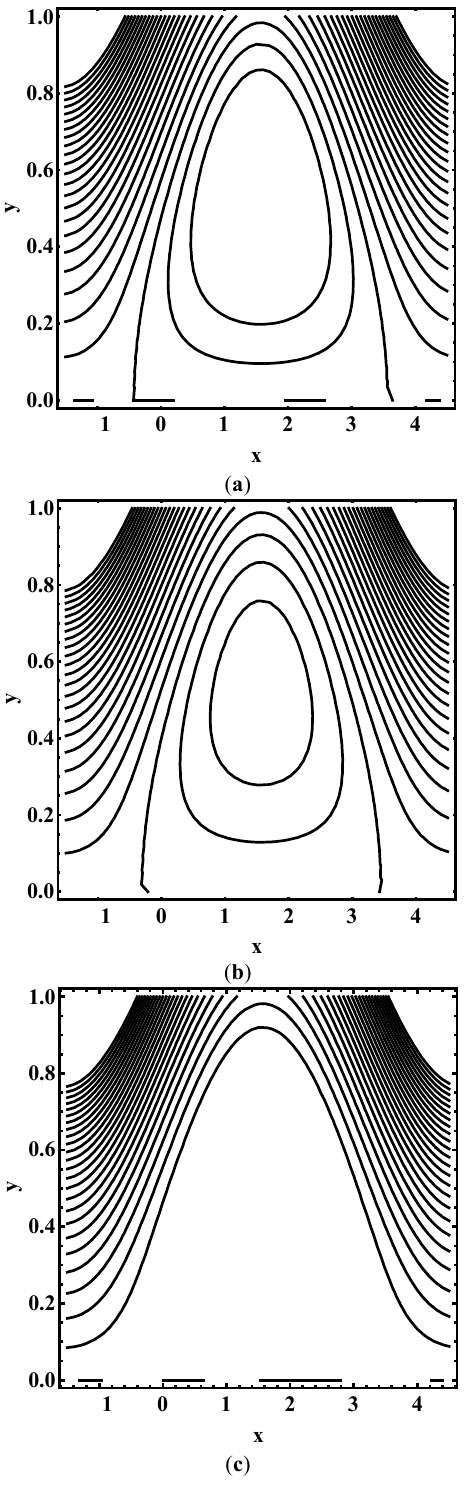
Figure 8. Streamline distribution for ( a ) . U hs = − 1.0 ( b ) . U hs = 0.0 ( c ) . U hs = 1.0, while other parameters are ε = 0.758, Θ = 0.7, Г = 0.01, m e =